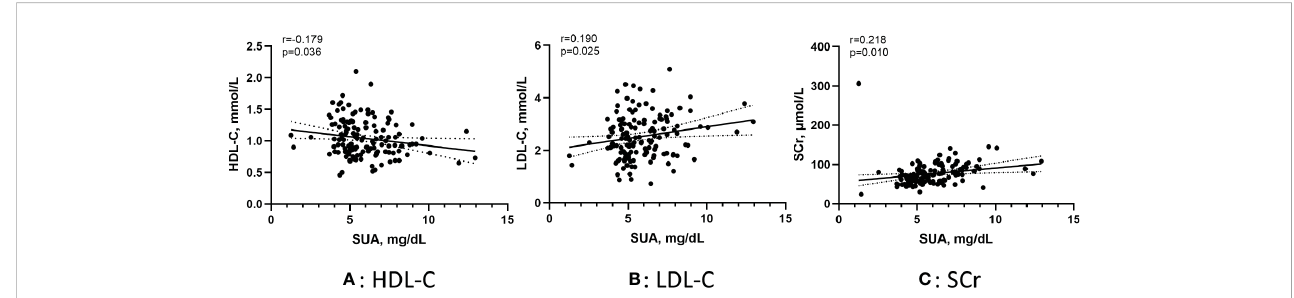
FIGURE 4 Pearson correlation of the SUA in AF patients with metabolic factors under the IFG pattern. (A) Correlation between SUA and HDL-C; (B) Correlation between SUA and LDL-C; (C) Correlation between SUA and SCr. SUA, serum uric acid; IFG, impaired fasting glucose; HDL-C, high-density lipoprotein